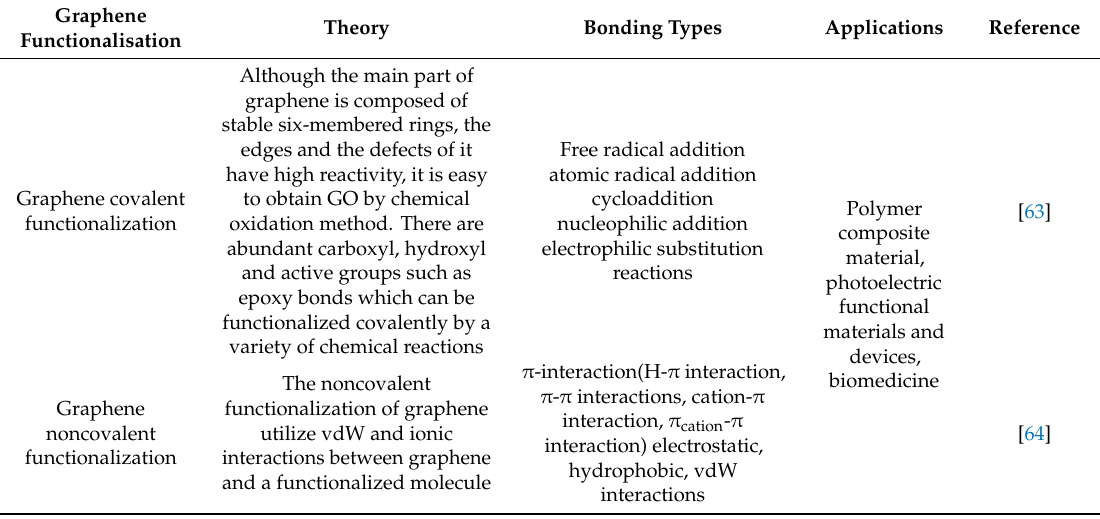
Table 1. The di ff erence between graphene covalent functionalization and noncovalent